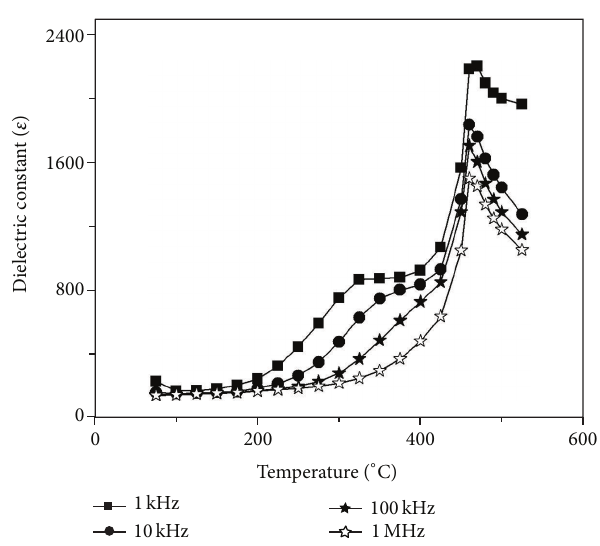
Figure 2: Temperature dependence of dielectric constant at differ- ent